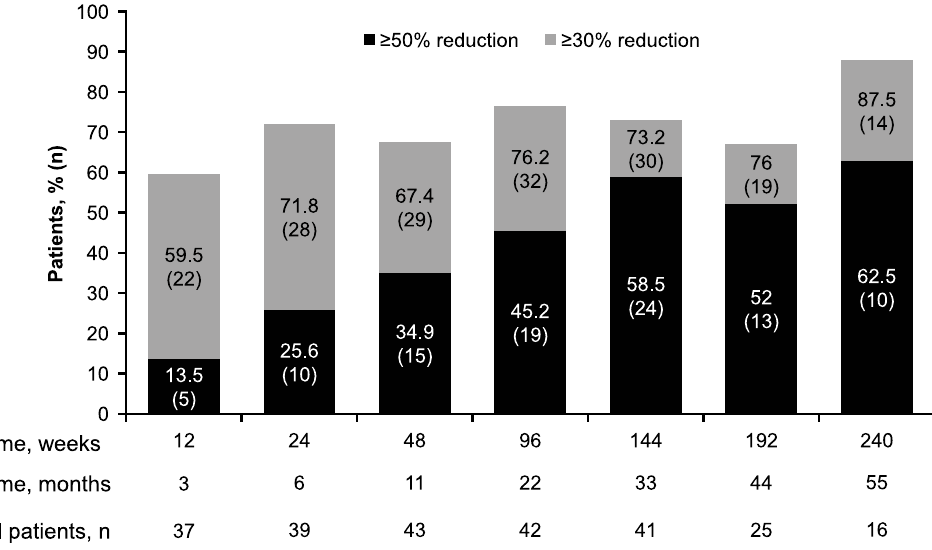
Fig 5. Reduction in SEGA volume with everolimus over time in patients with renal angiomyolipomas.